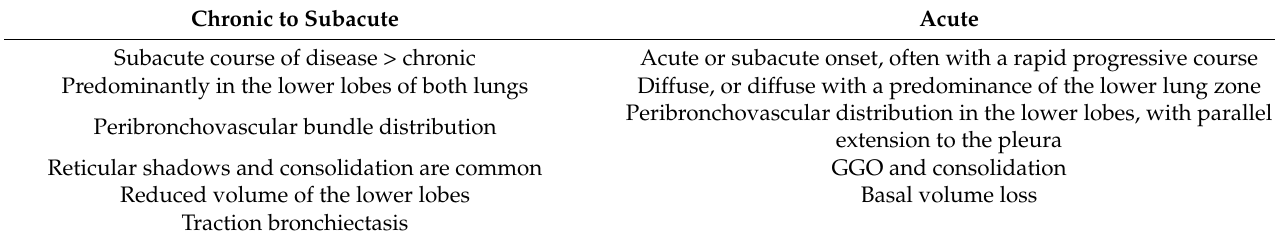
Table 1. Common imaging findings based on types of